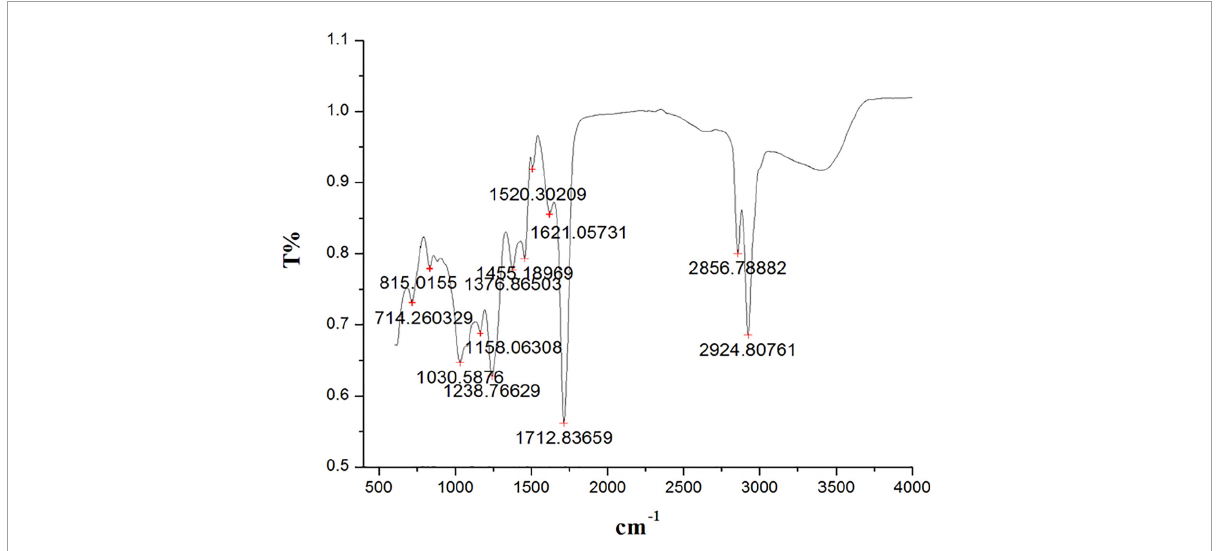
FIGURE3 Fourier transform infrared spectrometer (FTIR) spectrum from ethyl acetate root extract of Skimmia anquetilia